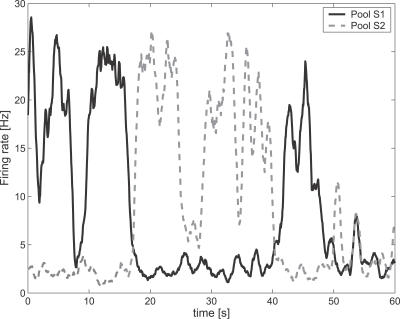
Wandering between Attractor StatesWe simulated a single long trial (60 s) in the spontaneous test condition for the synaptic modulation (−NMDA, −GABA). The two curves show the activity of the two selective pools over time smoothed with a 1-s sliding averaging window. The activity moves noisily between the attractor for the spontaneous state and the two persistent states S1 and S2 by virtue of statistical fluctuations caused by the randomness of the spiking activity.